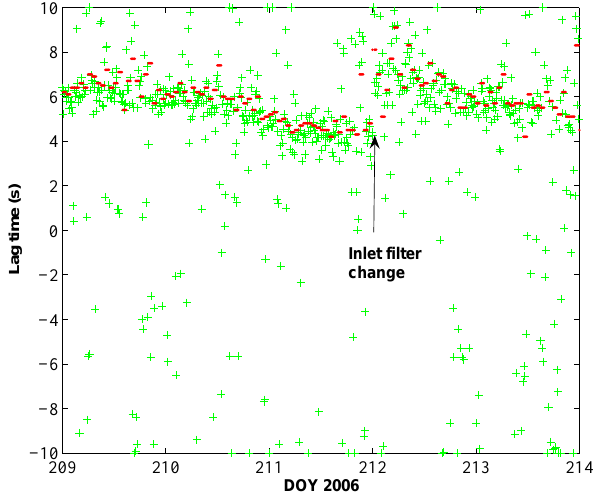
Fig. 6. Normalized step-response function obtained from a puff experiment. The dots represent the measured values, and the dashed curve is the result from a first-order low-pass response